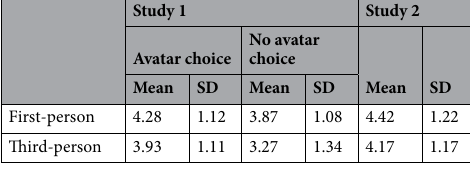
Table 1. Average sense of presence ratings.